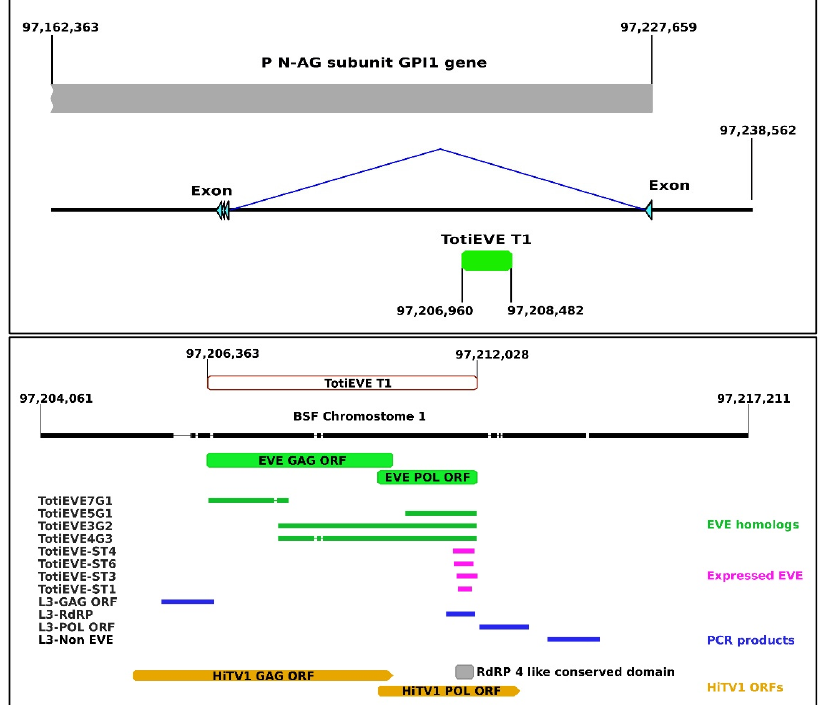
Figure 4. Mapping of Totiviridae-related sequences to TotiEVE T1 on chromosome 1 (black) on the BSF genome. TotiEVE T1 (green) is located between two exon sequences (light blue) of the BSF Phosphatidylinositol N-acetylglucosaminyltransferase subunit GPI1 gene (P N-AG subunit GPI1 gene) (XM_038053365.1) (grey) ( top ). In the ( bottom ), a closeup of TotiEVE T1 (brown) displaying the mapping of the orthologs found in BGA1, 2, and 3 (green), the expressed short transcripts (pink), the amplified PCR products (dark blue), and an overlay of the HiTV1 ORFS showing that the EVE is shorter than the exogenous virus (orange) and that the expressed EVE aligns to the RdRP conserved domain (grey). The sequences were mapped to a 20 001 nt sequence that flanks TotiEVE T1. The sequences can be found in; Table